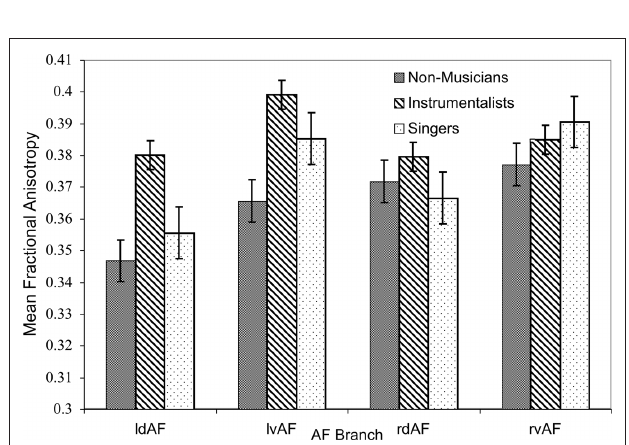
Figure 2 | Mean volume for all branches of the AF in both hemispheres for all groups (l = left, r = right, d = dorsal, v = ventral). Error bars represent SE of the mean.